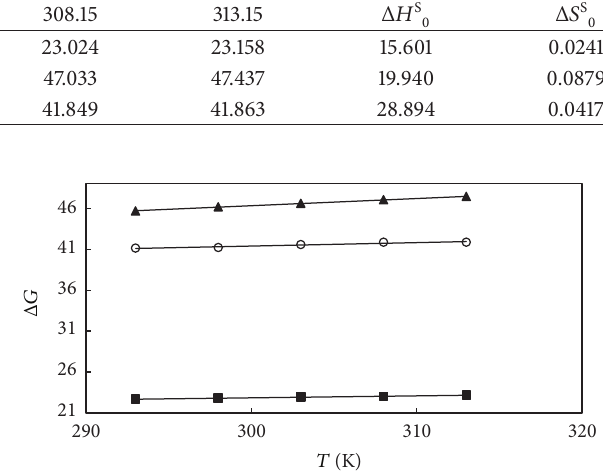
Figure5:Variationof Δ𝐺 S ,0 0 withthetemperatureforL1( ◼ ),L2( 󳵳 ), and L3 ( I